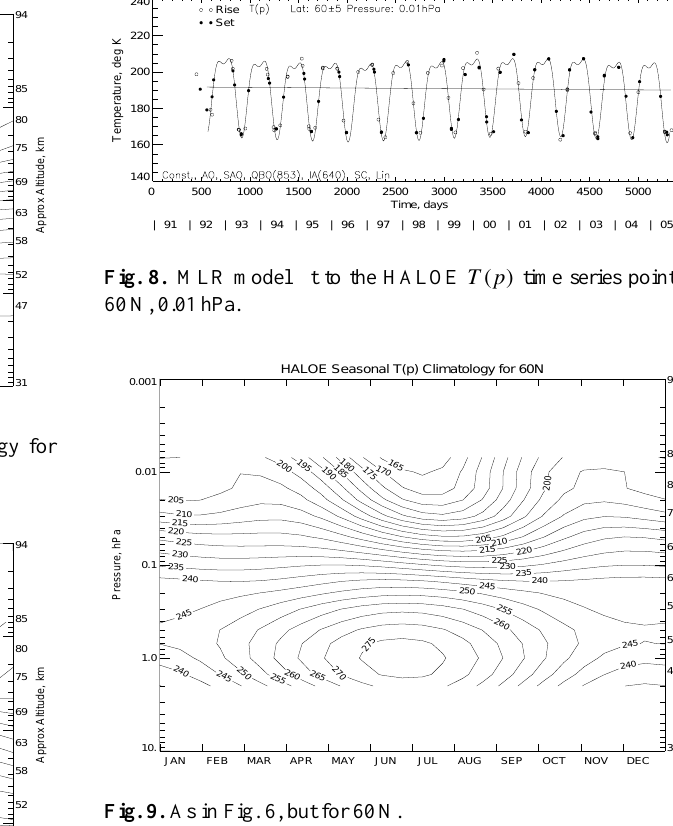
Fig. 9. As in Fig. 6, but for 60N.